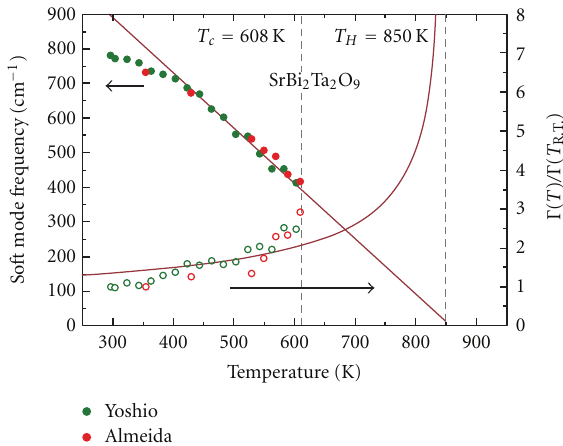
Figure 13: Temperature dependence of soft mode frequency (square of Raman frequency shift) and a normalized damping factor Γ ( T )/ Γ ( T R . T . ) in SrBi 2 Ta 2 O 9 [31–33].